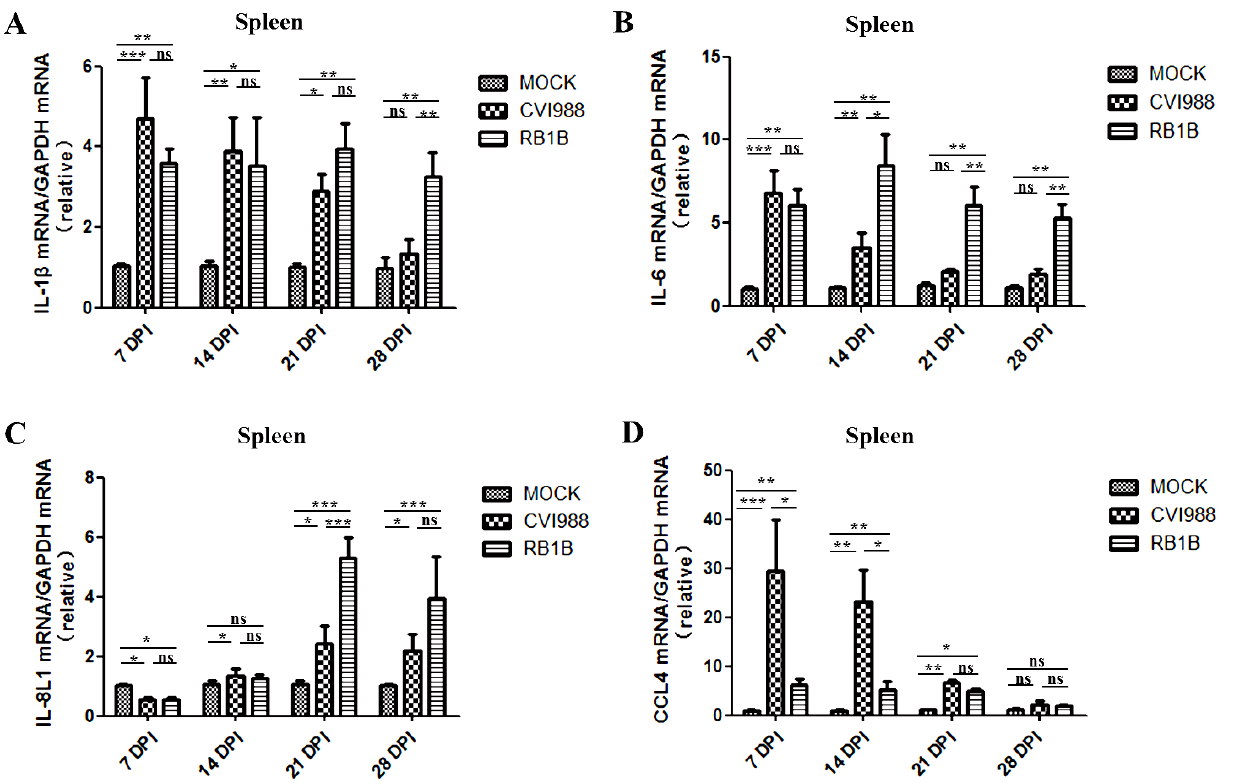
Figure 4. IL- 1β, IL -6, IL-8L1, andCCL4 transcripts in the spleen inoculated with MDV/CVI988 and Figure 4. IL-1 β , IL-6, IL-8L1, andCCL4 transcripts in the spleen inoculated with MDV/CVI988